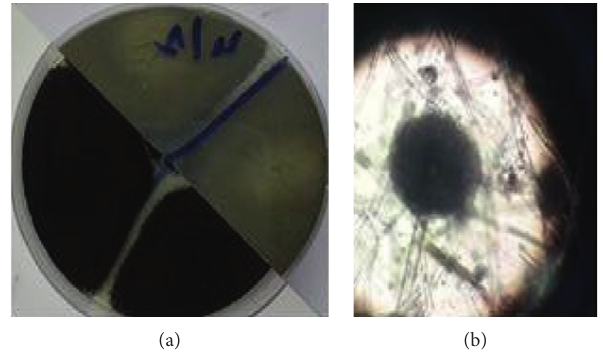
Figure 3: Aspergillus niger found in the sterilization service (storage area).